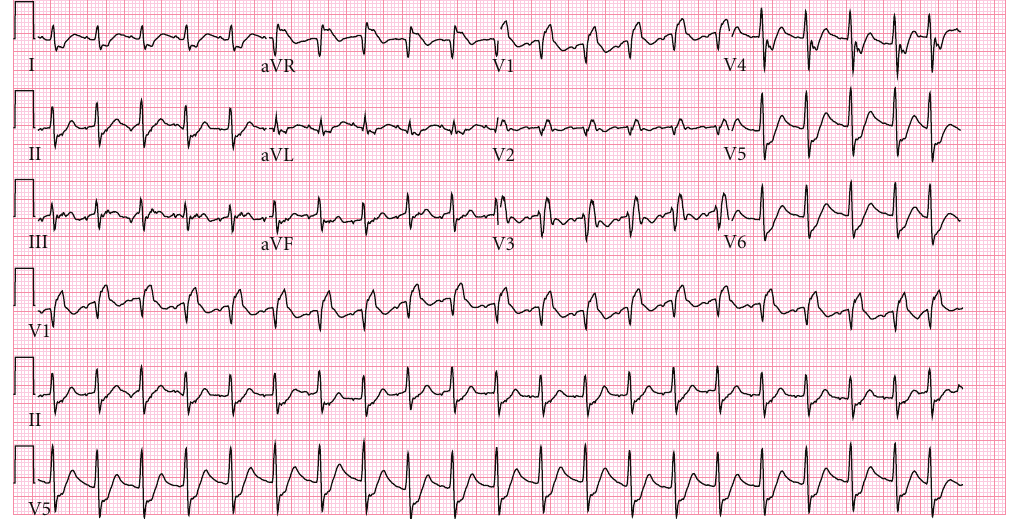
Figure 2: EKG demonstrates new right bundle branch